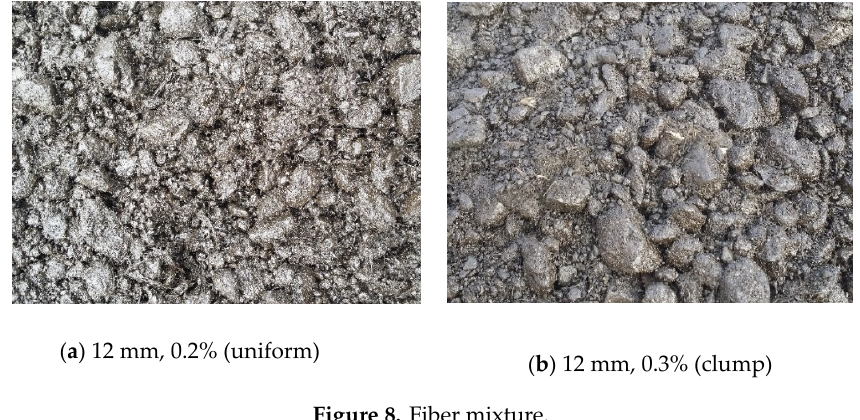
Figure 8. Fiber mixture.